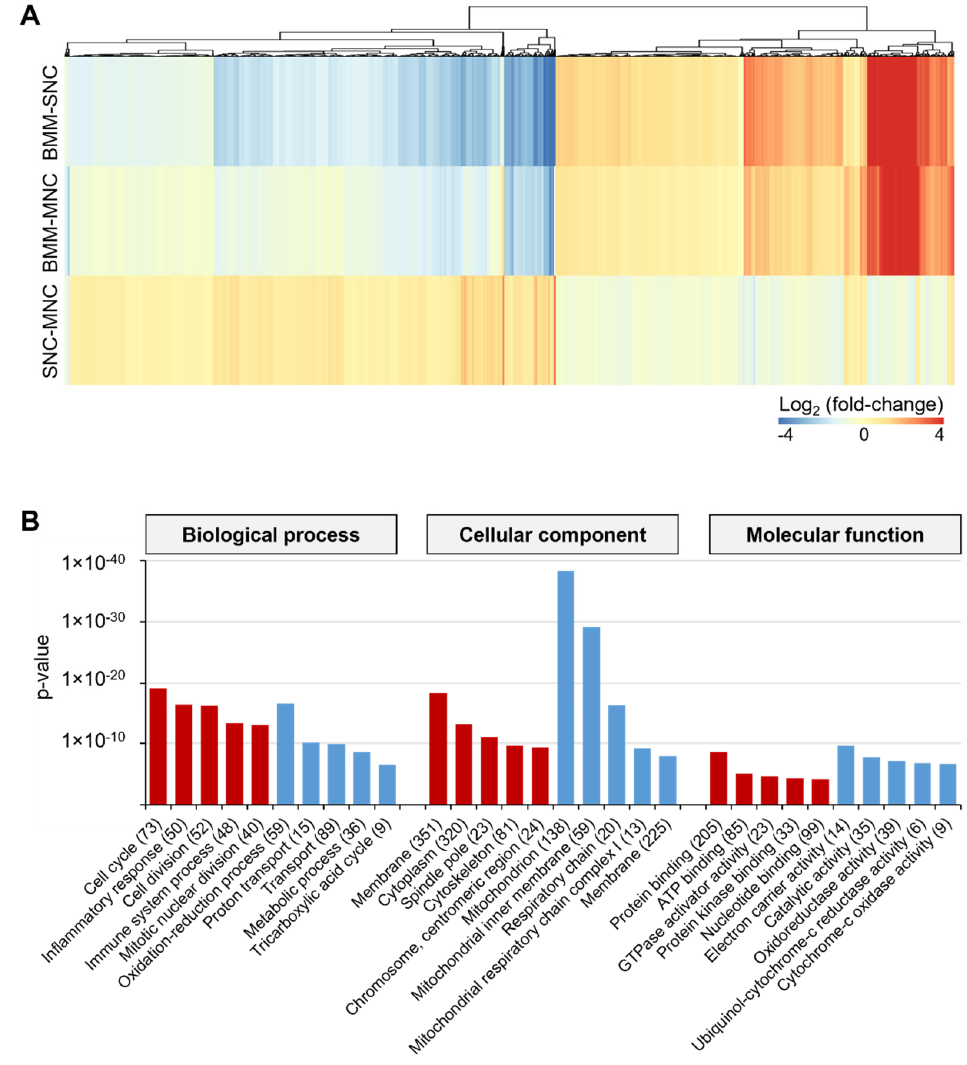
Figure 2. Depiction of 1228 DEGs common to all comparisons. ( A ) Heatmap analysis indicating the highly upregulated or downregulated genes from 1228 common genes in the SNC-MNC comparison (q-value < 0.05). ( B ) Gene ontology (GO) analysis results for the 1228 overlapping genes. Blue bars indicate SNC-specific upregulated genes, whereas red bars indicate MNC-specific upregulated genes from the comparison between SNCs and MNCs.